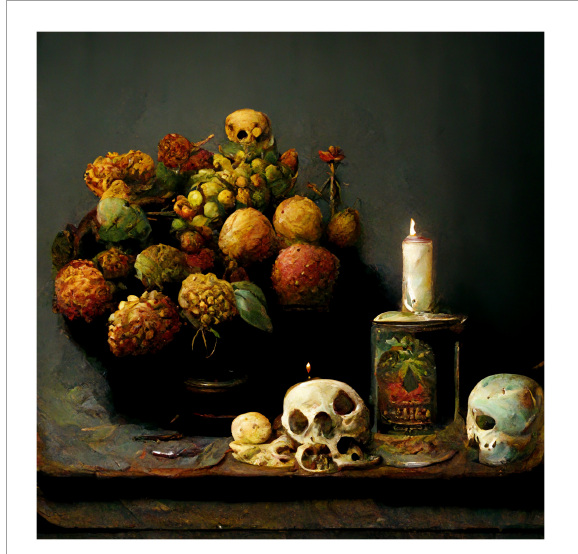
FIGURE3 Midjourney image generated to the prompt “a still life with fruit, flowers, a vase, dead game, a candle, and a skull in a Pop-art style”.